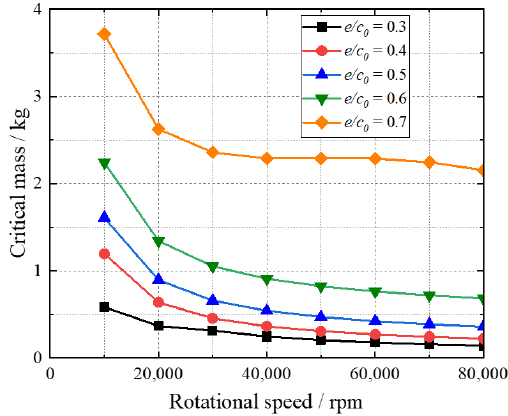
Figure 17. Critical mass of hydrogen gas bearings with eccentricity ratio.